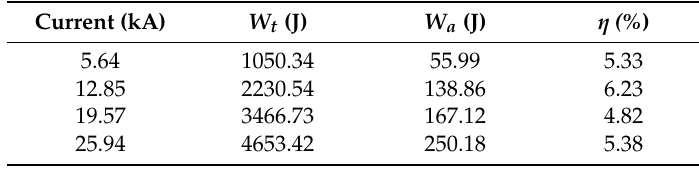
Figure 10. Typical waveforms of voltage and current. Table 3. Experimental results.